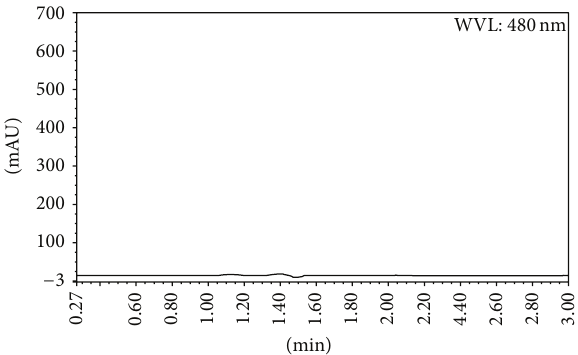
Figure 3: HPLC chromatograms obtained from excipients com- pounded from tablets.